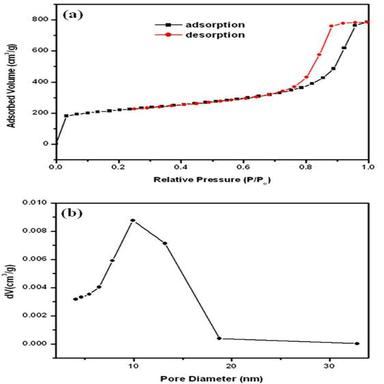
Carbon aerogel. (a) N2 adsorption/desorption isotherms. (b) Pore size distribution. Reprinted with permission from Ref..